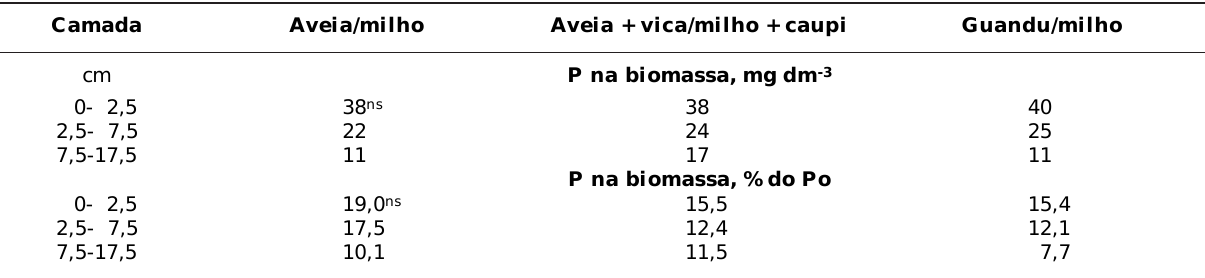
ns não-significativo (p <